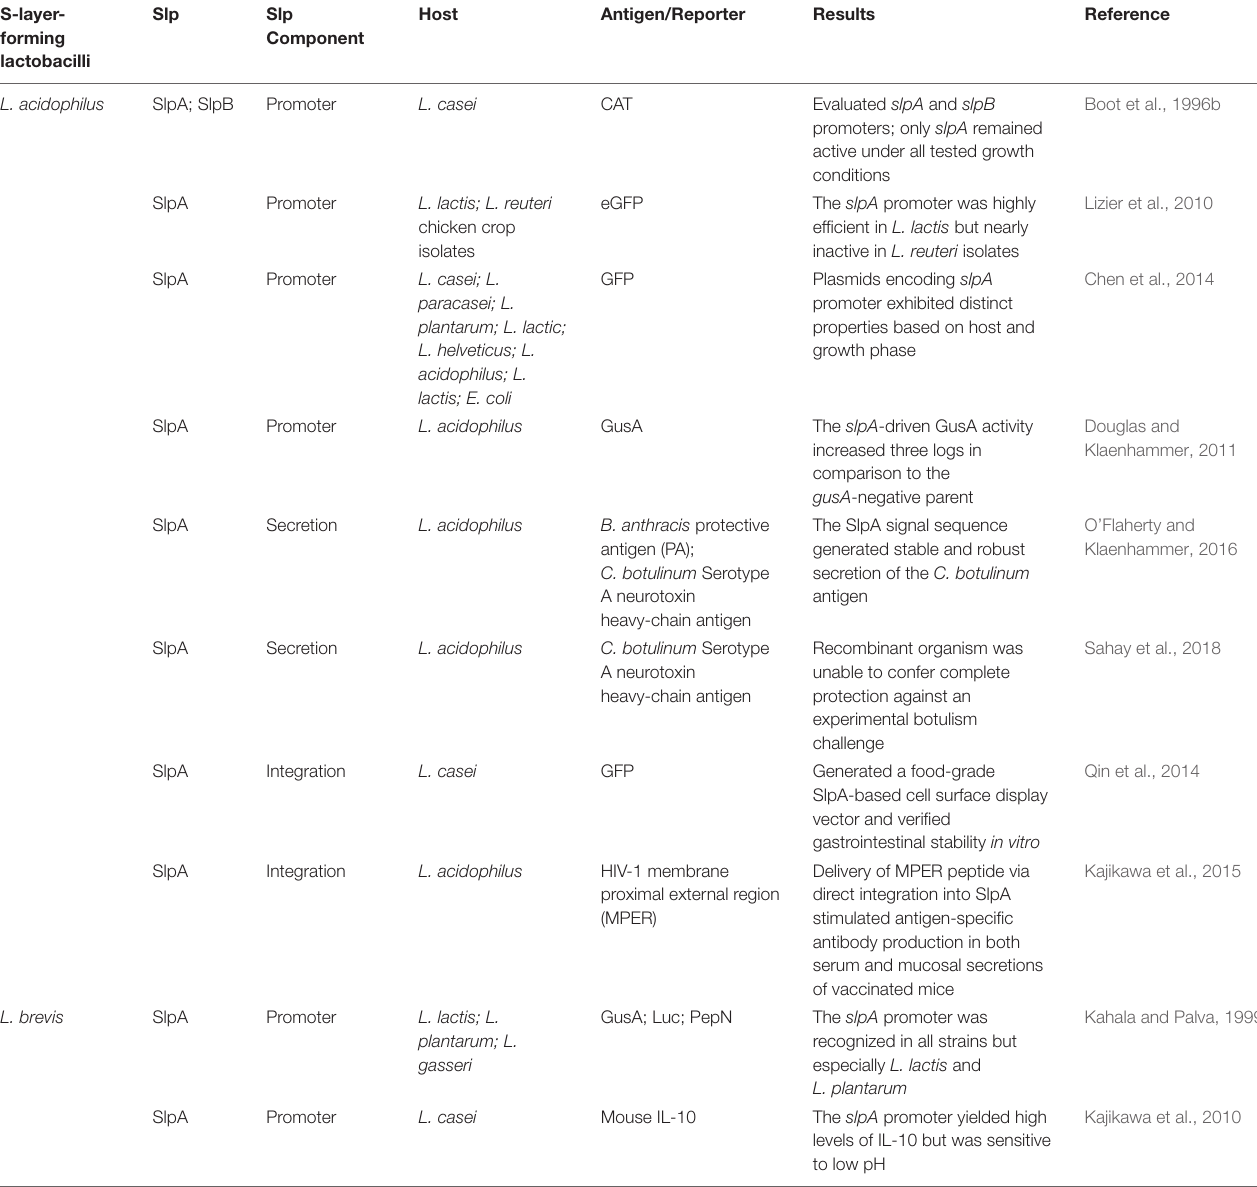
TABLE 1 | S-layer protein applications in recombinant protein expression systems and biotherapeutic delivery platforms. S-layer- forming